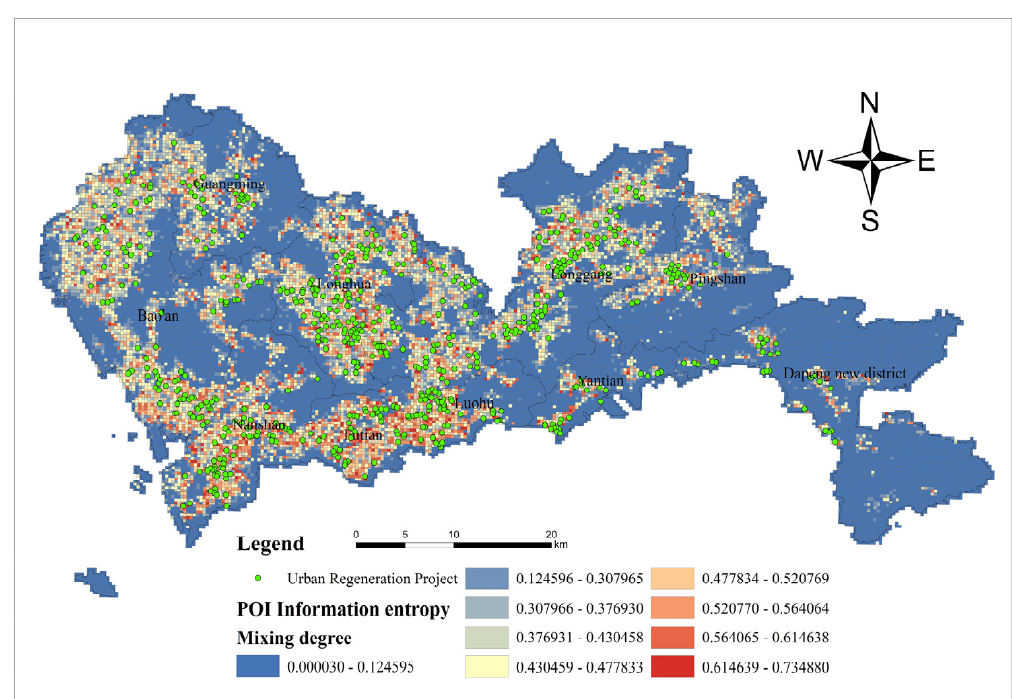
Figure 6. UR and POI mixing degree.